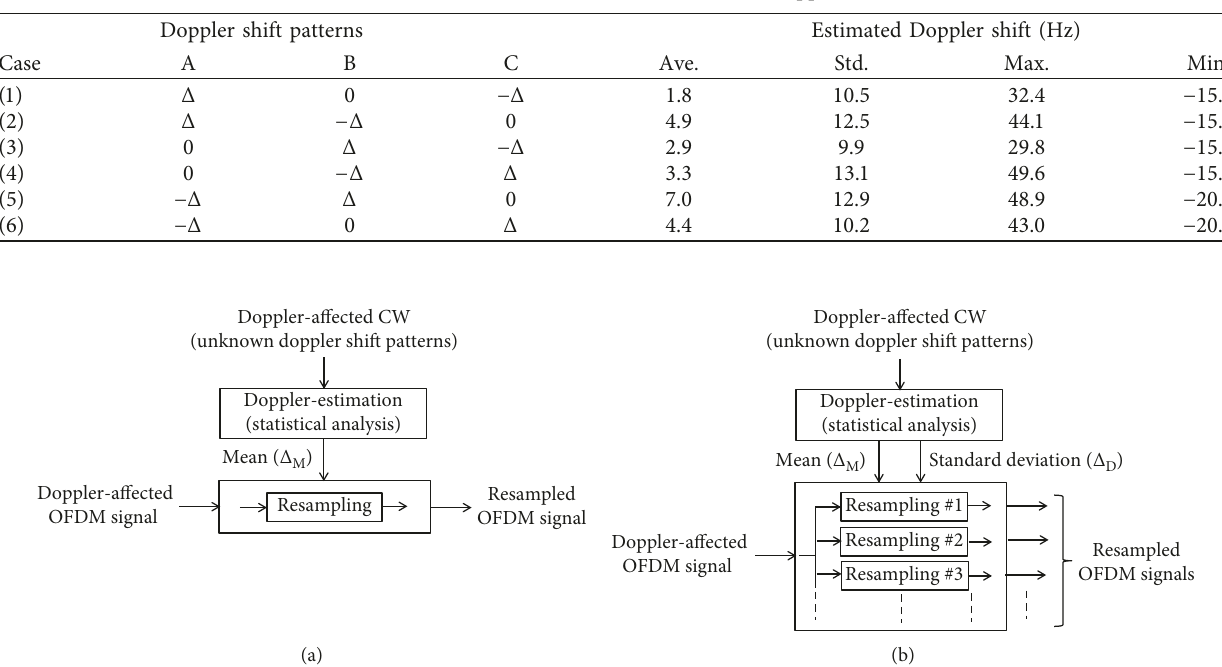
Table 4: Statistical results based on short-term Doppler shifts.